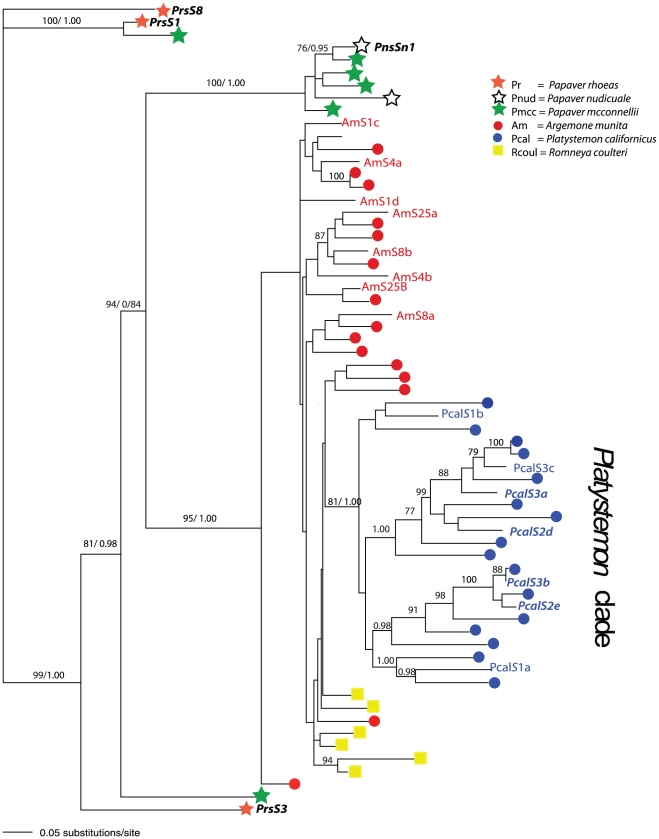
Maximum likelihood phylogeny of known Papaver S-alleles and putative S-alleles from other taxa.The Papaver S-alleles (alleles PrsS1, PrsS3 PrsS8 and PnSn1 in bold) identified by [5] and [6] form highly divergent lineages that include recently identified sequences from P. mcconnellii but show no close associations with any non-Papaver sequences. All sequences from P. californicus form a distinct monophyletic clade while sequences from A. munita and R. coulteri show some poorly supported shared polymorphism. P. californicus linked sequences S2d and S2e from parental plant 2 are found in separate sub-clades as are co-inherited sequences S3a and S3b from parent 3 (italics). Sequences used in crosses for A. munita and P. californicus are indicated as text.